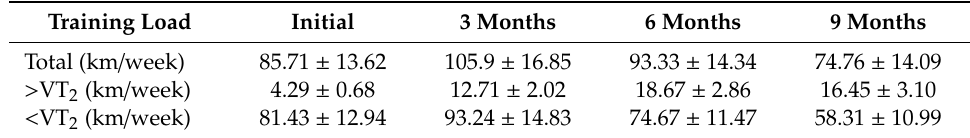
Table 1. Training characteristics in the athletes during the season.